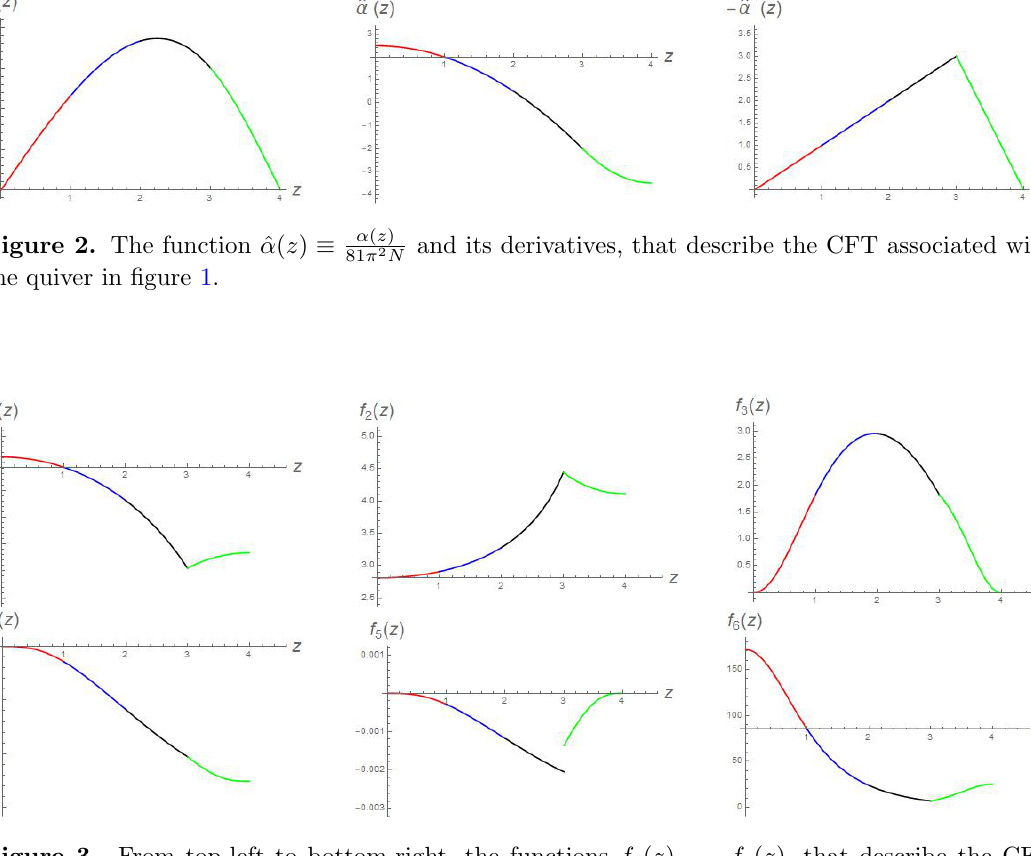
Figure 3. From top-left to bottom-right, the functions f 1 ( z ) ; : : : ; f 6 ( z ), that describe the CFT associated with the quiver in (cid:12)gure 1.